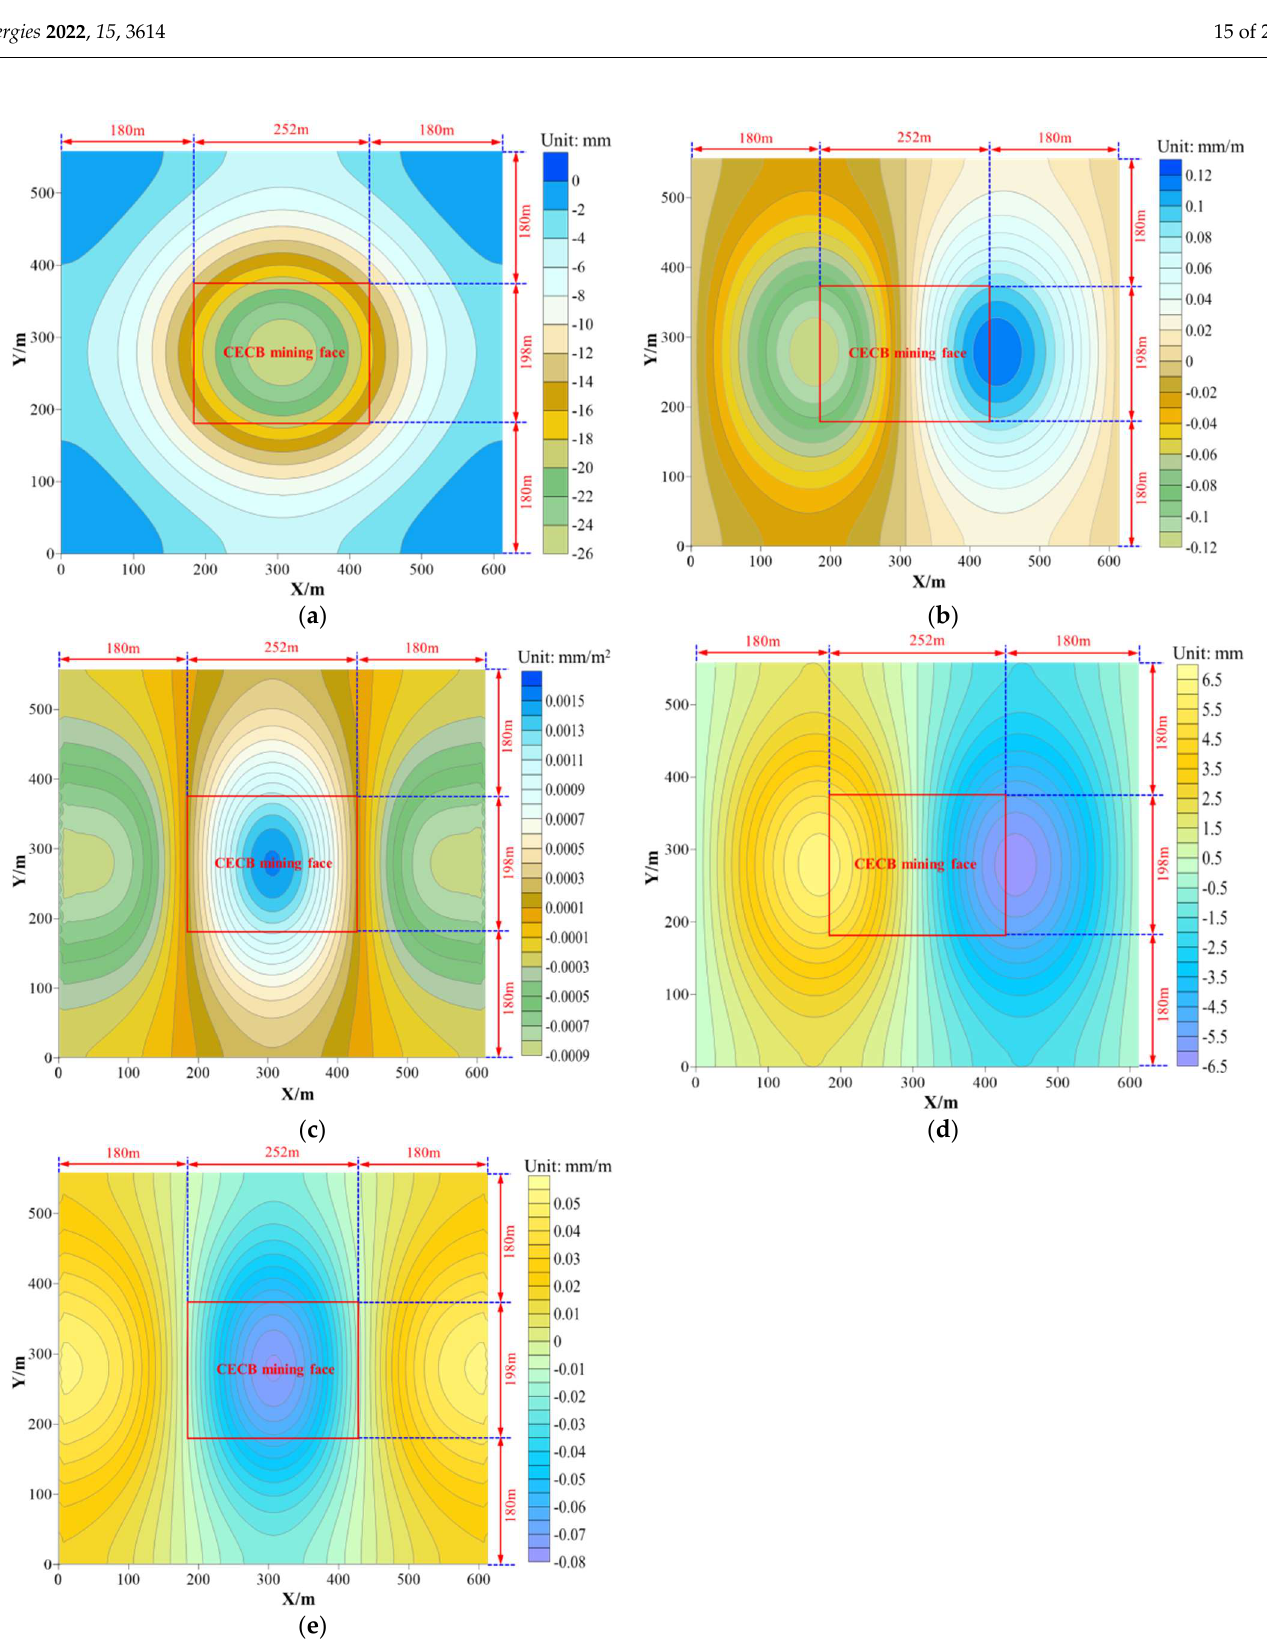
Figure 12. Numerical simulation results of the movement of aquifuge while using CECB and CMFB with 75% fly ash. ( a ) Vertical displacement; ( b ) tilt; ( c ) curvature; ( d ) horizontal displacement; ( e ) horizontal deformation.